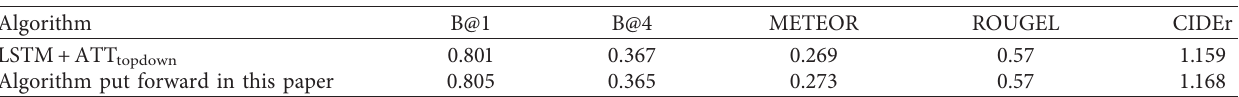
Table 2: Contrast after the addition of two generation algorithms for the multimedia image description to concentrated search.